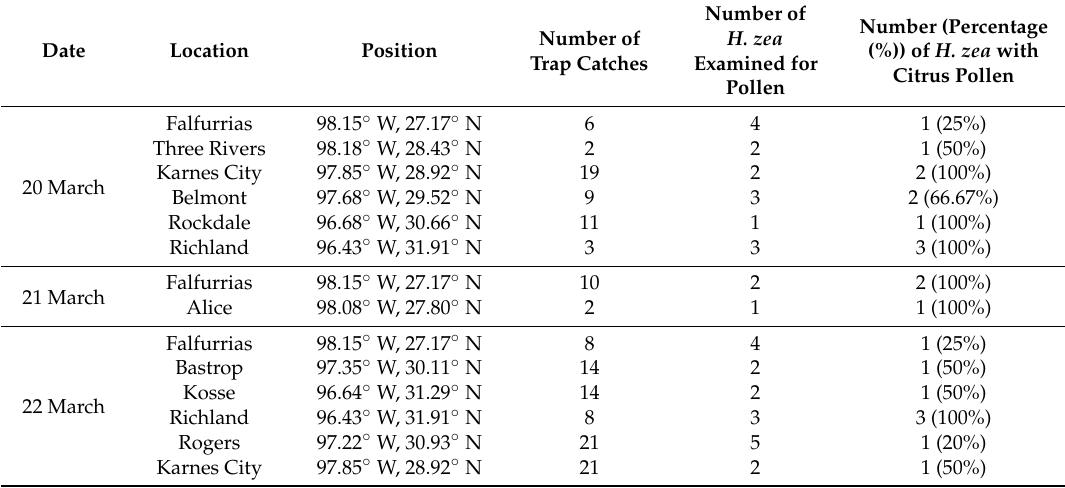
Table 1. Pheromone trap catches of citrus pollen-marked H. zea males on 20–22 March 1995 in Texas, USA. Location Position